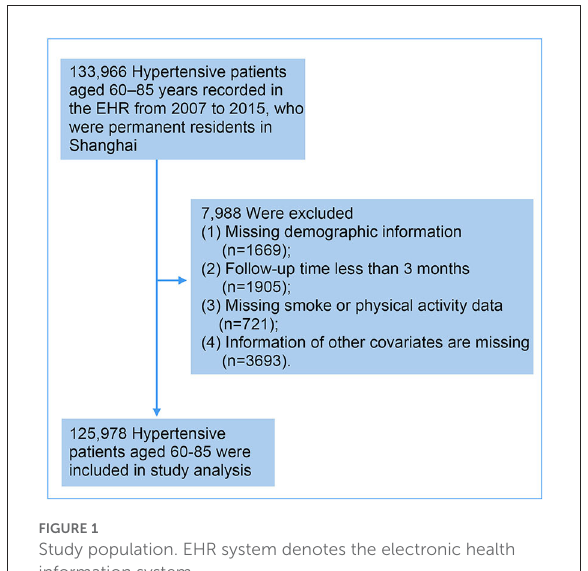
FIGURE1 Study population. EHR system denotes the electronic health information